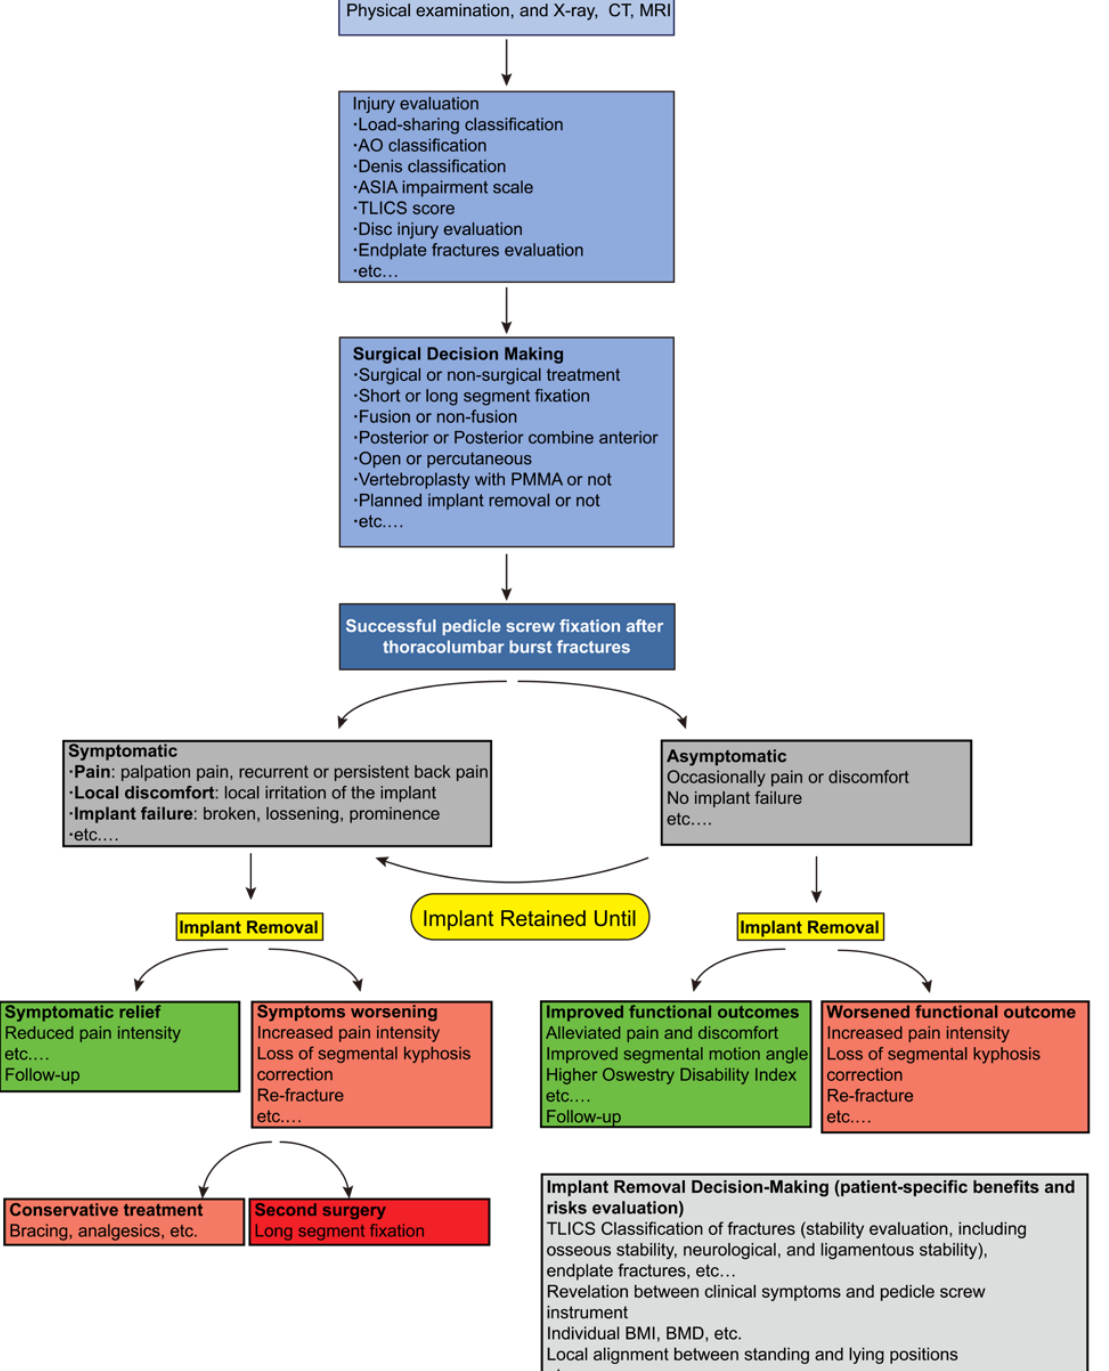
Figure 2. A proposed flow diagram for the management of thoracolumbar burst fractures. Abbre- viations: CT, Computed Tomography; MRI, Magnetic Resonance Imaging; ASIA, American Spinal Injury Association; TLICS, Thoracolumbar Injury Classification and Severity; PMMA, Polymethyl Methacrylate; BMI, Body Mass Index; BMD, Bone Mineral